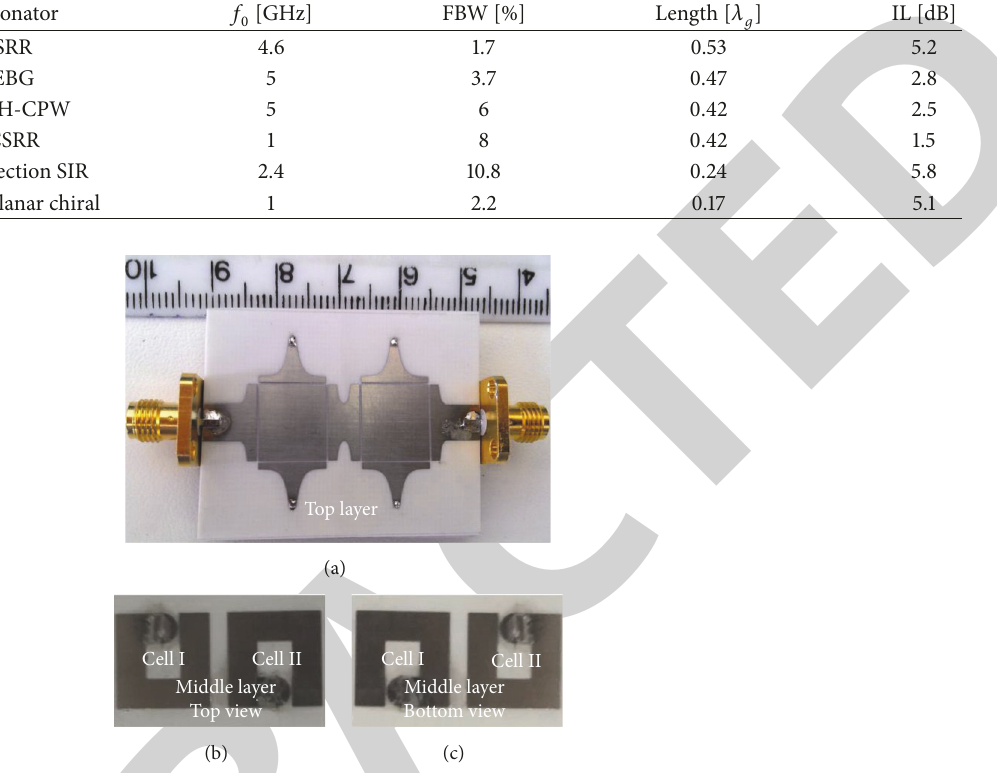
Table 1: Comparison between this work and other published works. Ref.